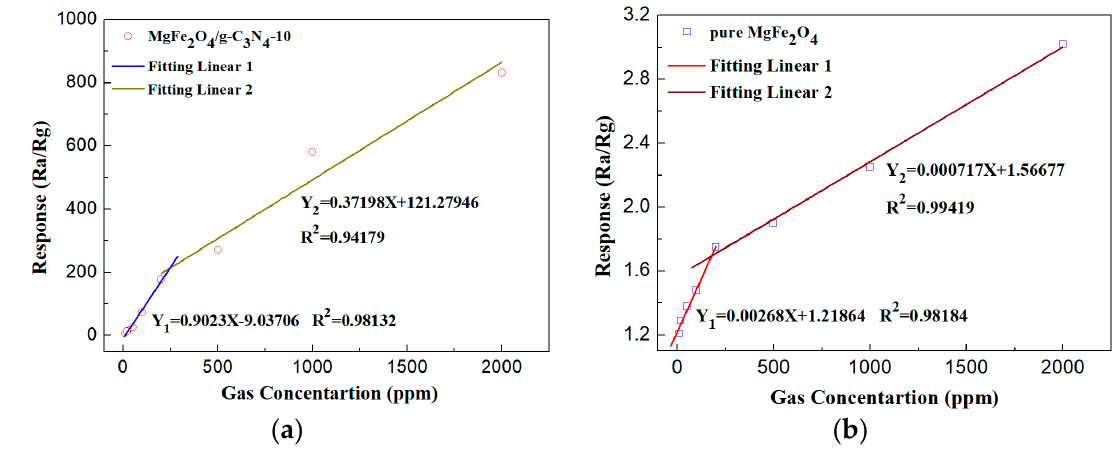
Figure 7. The response value of the sensors based on ( a ) MgFe 2 O 4 /g-C 3 N 4 -10 and ( b ) MgFe 2 O 4 porous microspheres to the varied concentrations of acetone at the working temperature of 320 °C and their fitting linear.